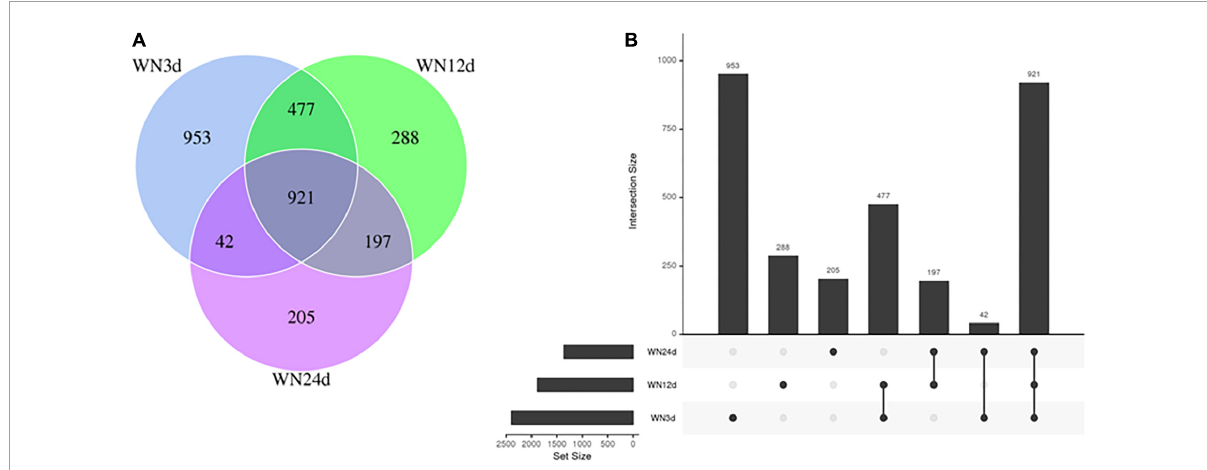
FIGURE3 (A) Venn diagram of OUTs and (B) histogram of OUTs during the composting